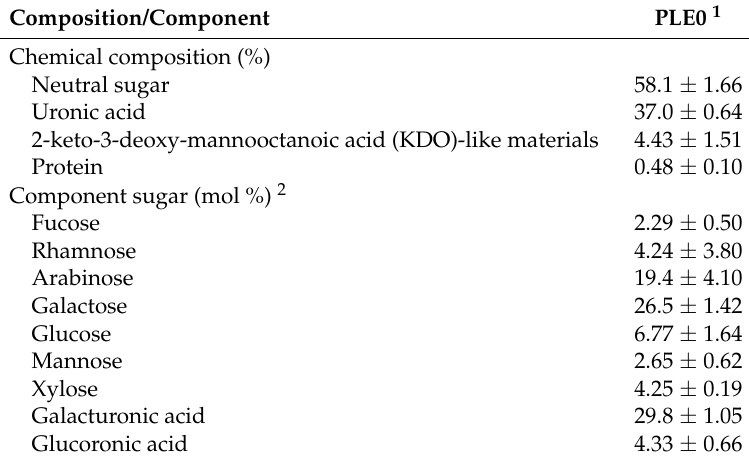
Table 1. Chemical composition of a polysaccharide fraction (PLE0) isolated from persimmon